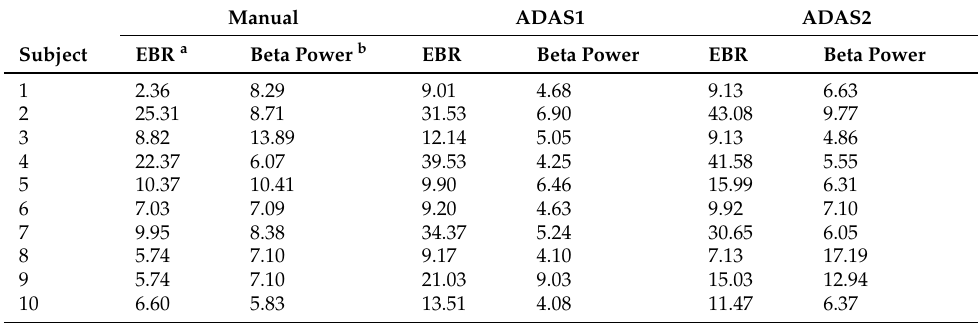
Table 1. Blink rate (FP1 derivation) and beta power (O2 derivation) for all scenarios and each subject. Manual ADAS1